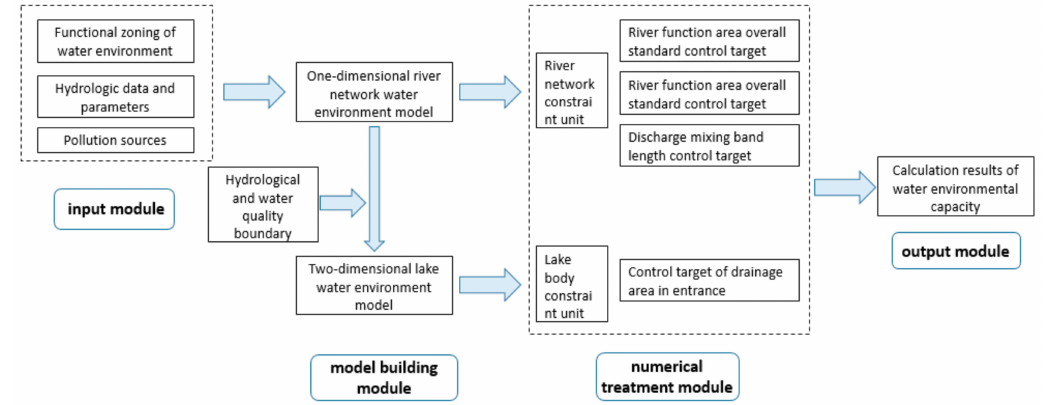
Figure 2. Water environment capacity calculation system based on multiple targets of rivers and